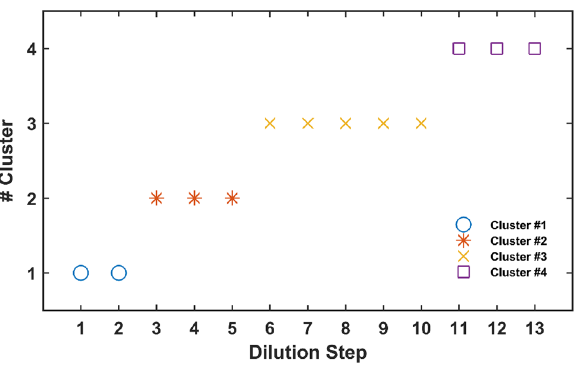
Figure 5. Resulting classes from the application of k -means clustering for dilution series data.